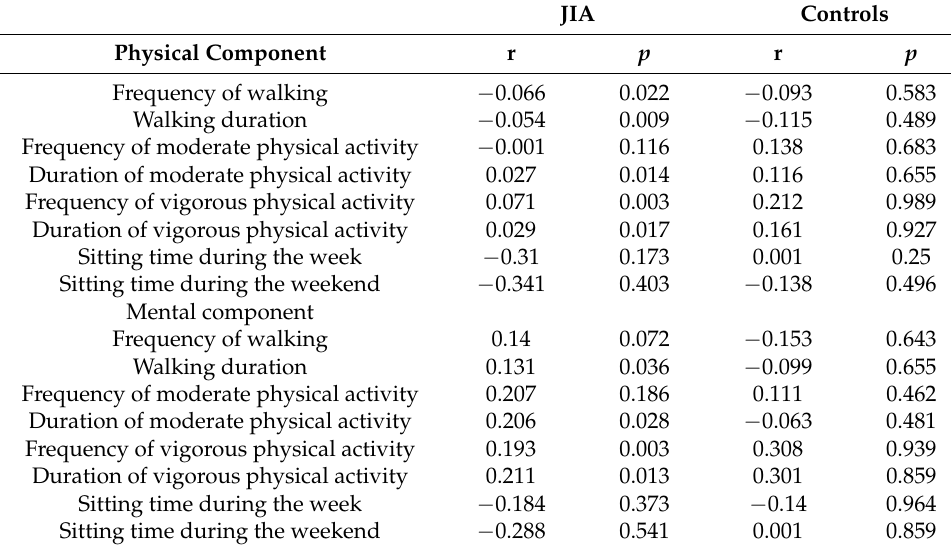
Table 5. Correlation between the mean scores of the IPAQ with the scores of the physical and mental components of the Health-Related Quality of Life Assessment Questionnaire (SF36) of patients with JIA and the control group.